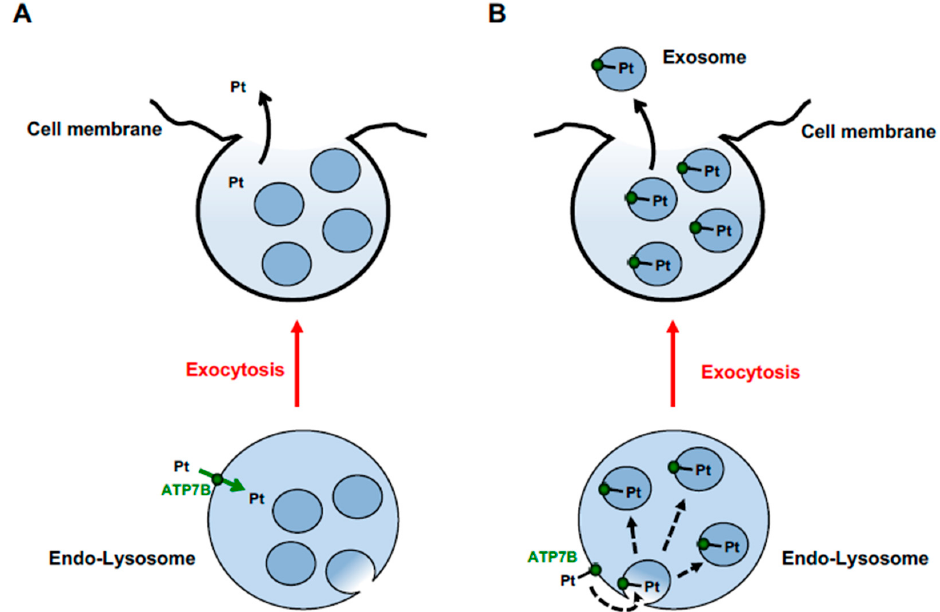
Figure 4. Hypothetical mechanisms of ATP7B-mediated Pt excretion through endo-lysosomal vesicular structures. (A) ATP7B transports Pt, or its derivates, from the cytosol to the lumen of vesicular endo-lysosomal structure across its membrane (green arrow). Pt is released from the lumen of vesicular structure (black arrow) during the process of its fusion with the plasma membrane (exocytosis, red arrow). ( B ) N-terminal MBSs of ATP7B bind Pt at the cytosolic surface of endo-lysosomal structures. ATP7B-bound Pt is sorted into intraluminal vesicles dash arrow budding towards the lumen of endo-lysosomal organelle. During exocytosis (red arrow) Pt-loaded intralumenal vesicles are released into the extracellular space as exosomes (black arrow).